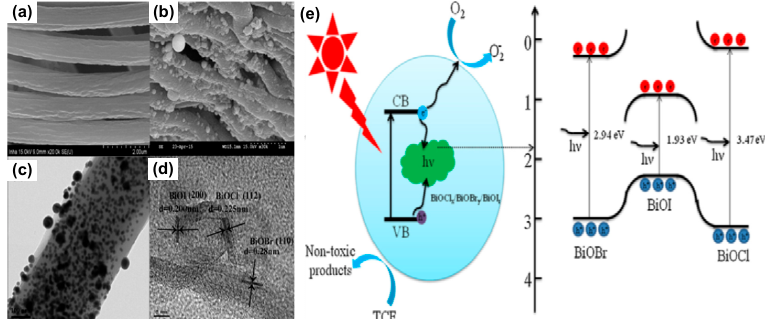
Figure 20. SEM image of pristine PAN fibers ( a ) and BiOCl x /BiOBr y /BiOI z composite fibers ( b ). ( c ) FE-TEM image of BiOCl x /BiOBr y /BiOI z fibers. ( d ) Lattice-resolved image for BiOCl x /BiOBr y /BiOI z nanofibers. ( e ) Schematic indicating the photocatalytic degradation of TCE. Adapted with permission from Reference [109]. Copyright (2016)